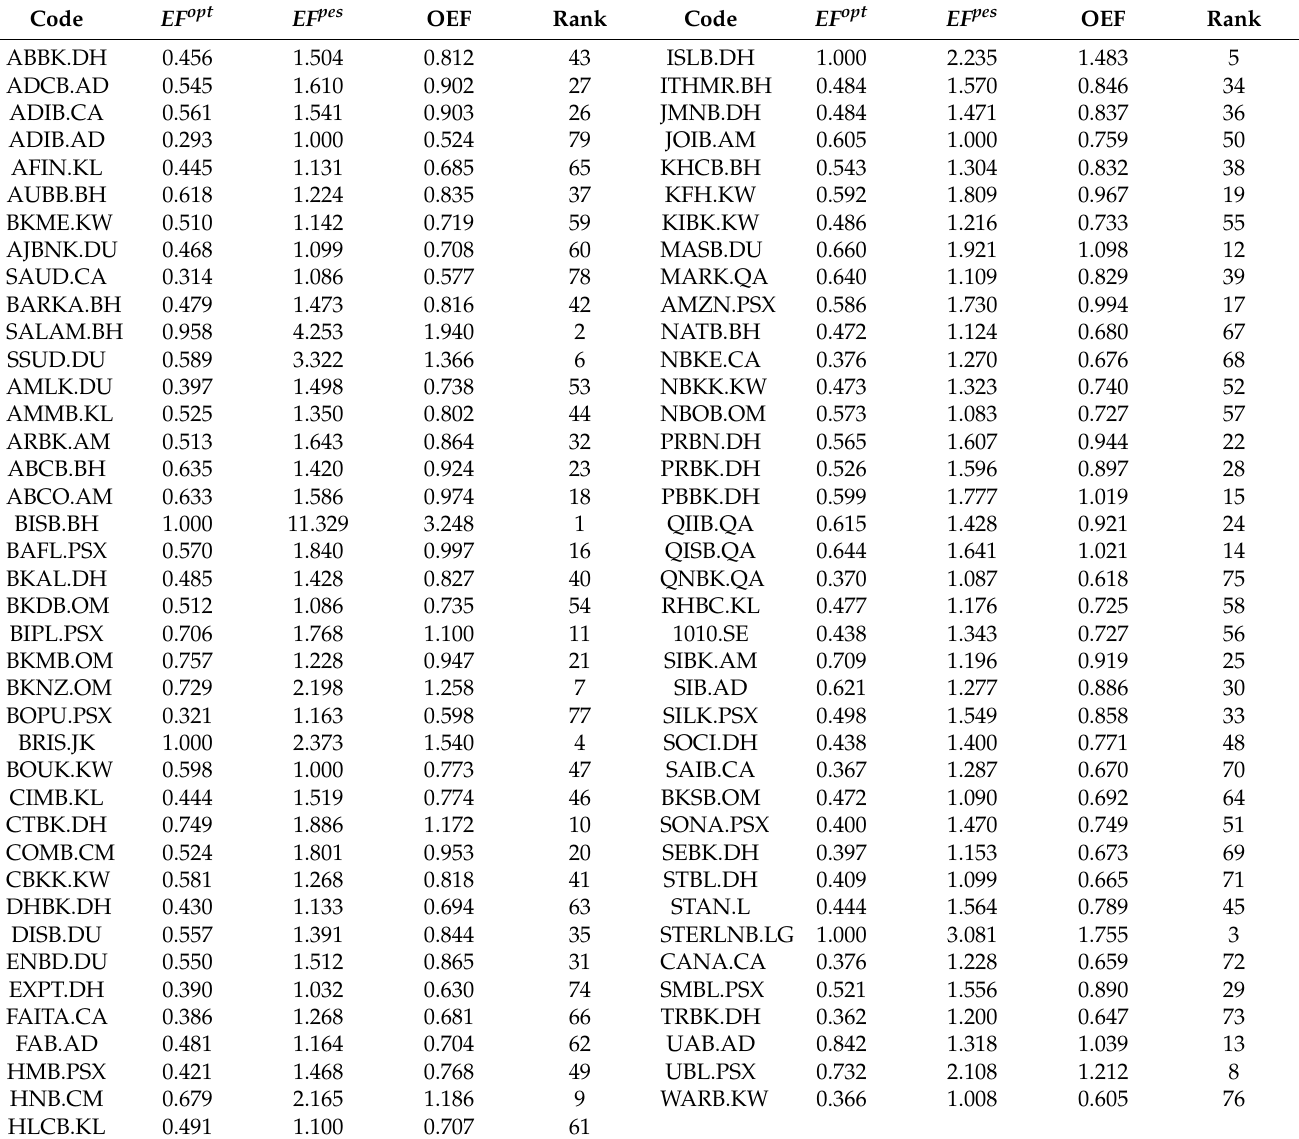
Table 3. Average efficiency of the examined